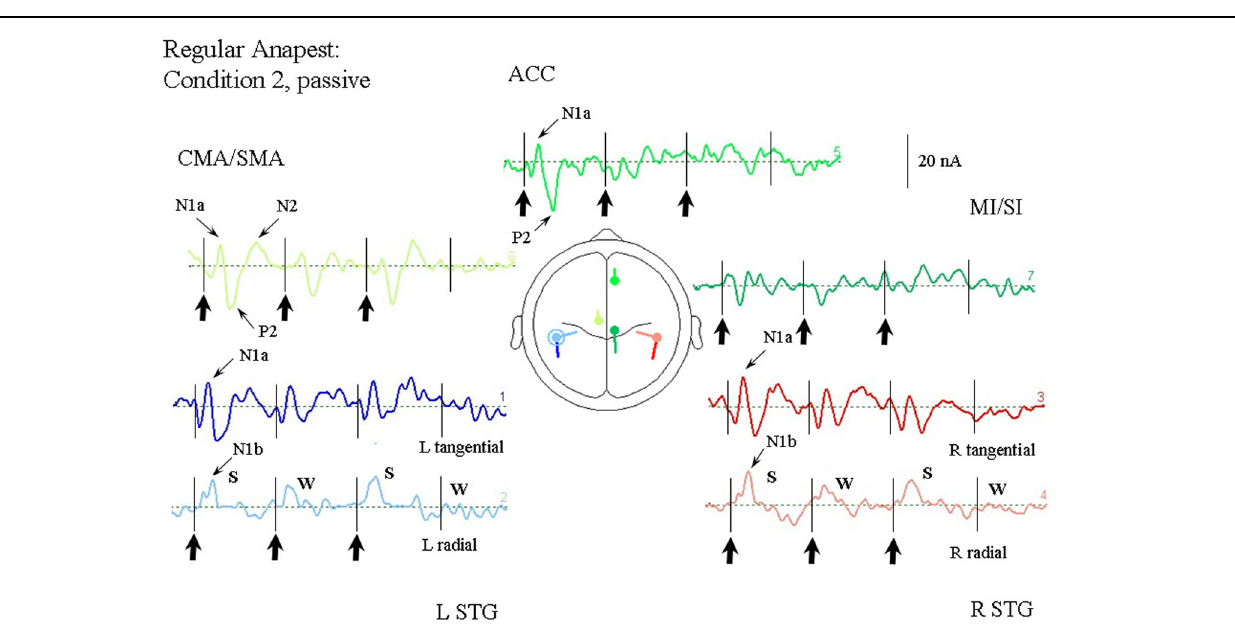
about 15 nA. The largest contributor to the N2a and N2b